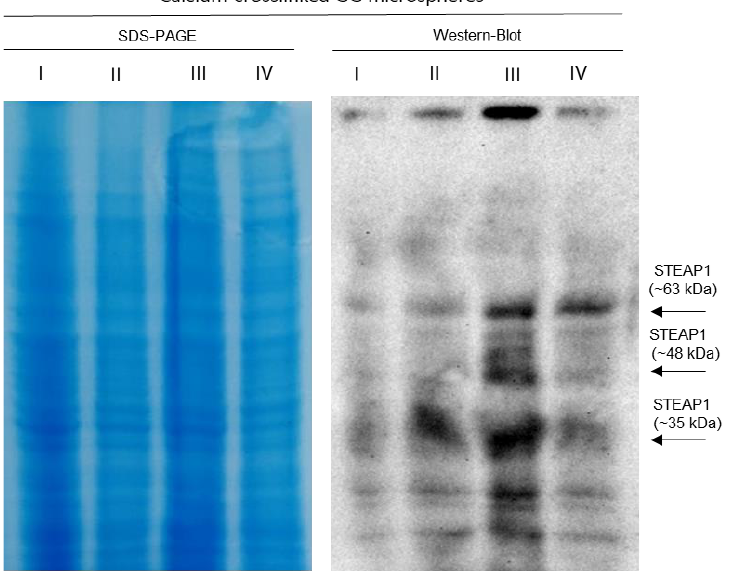
Figure 5. SDS-PAGE and Western blot of the recovered supernatants from the optimized batch for calcium-crosslinked GG microspheres (35 mL GG microspheres); I — sample that did not bind to GG microspheres at 10 mM MES pH 6.2; II — washing step with 10 mM Tris pH 8; III — elution step with microspheres at 10 mM MES pH 6.2; II—washing step with 10 mM Tris pH 8; III—elution step with 10 mM Tris pH 9.2; IV — elution step with 10 mM Tris pH 11. 10 mM Tris pH 9.2; IV—elution step with 10 mM Tris pH